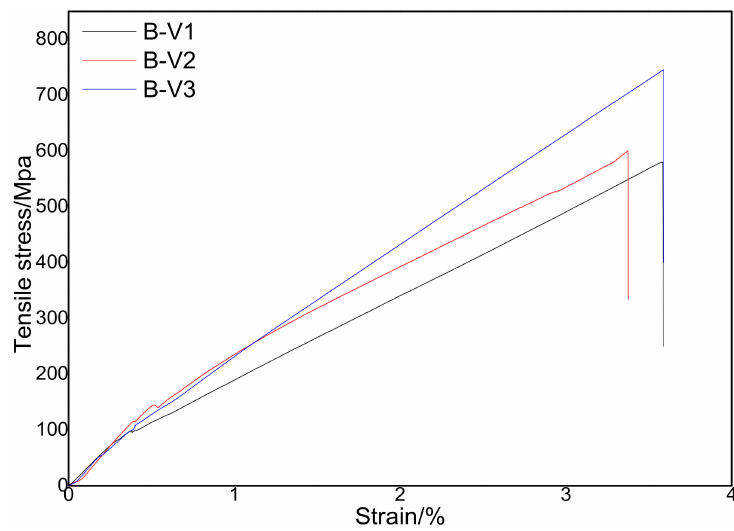
Figure 4. Typical tensile stress-strain curves of 3D braided composites.